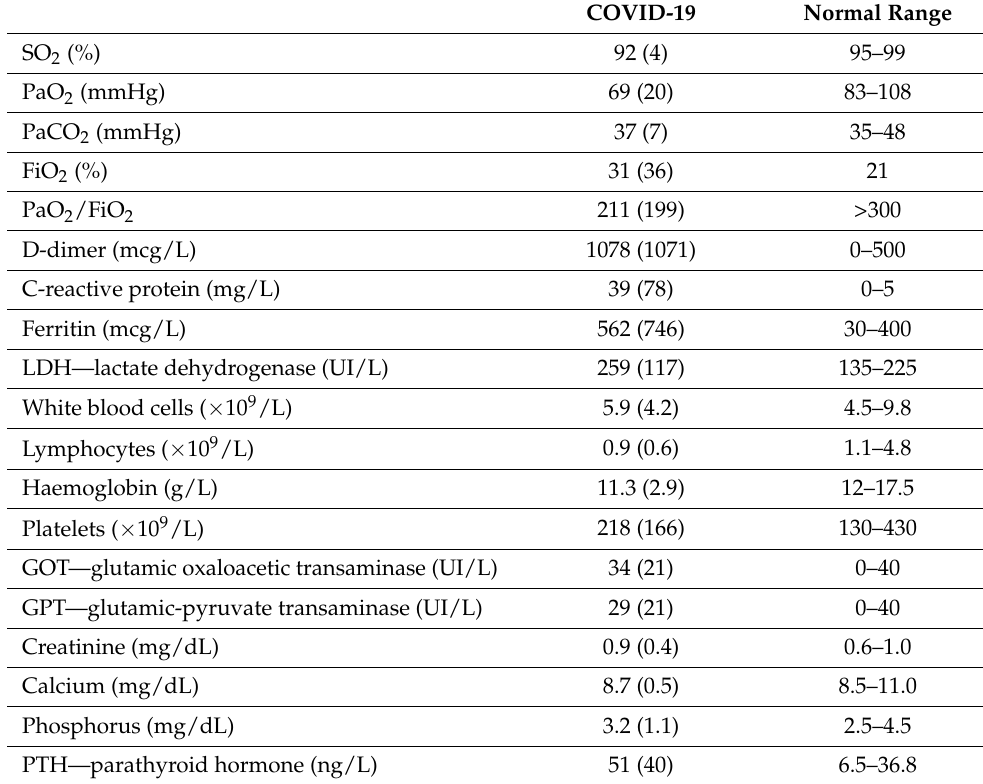
Table 2. Baseline clinical parameters of COVID-19 patients. Values are reported as median and interquartile range (IQR).